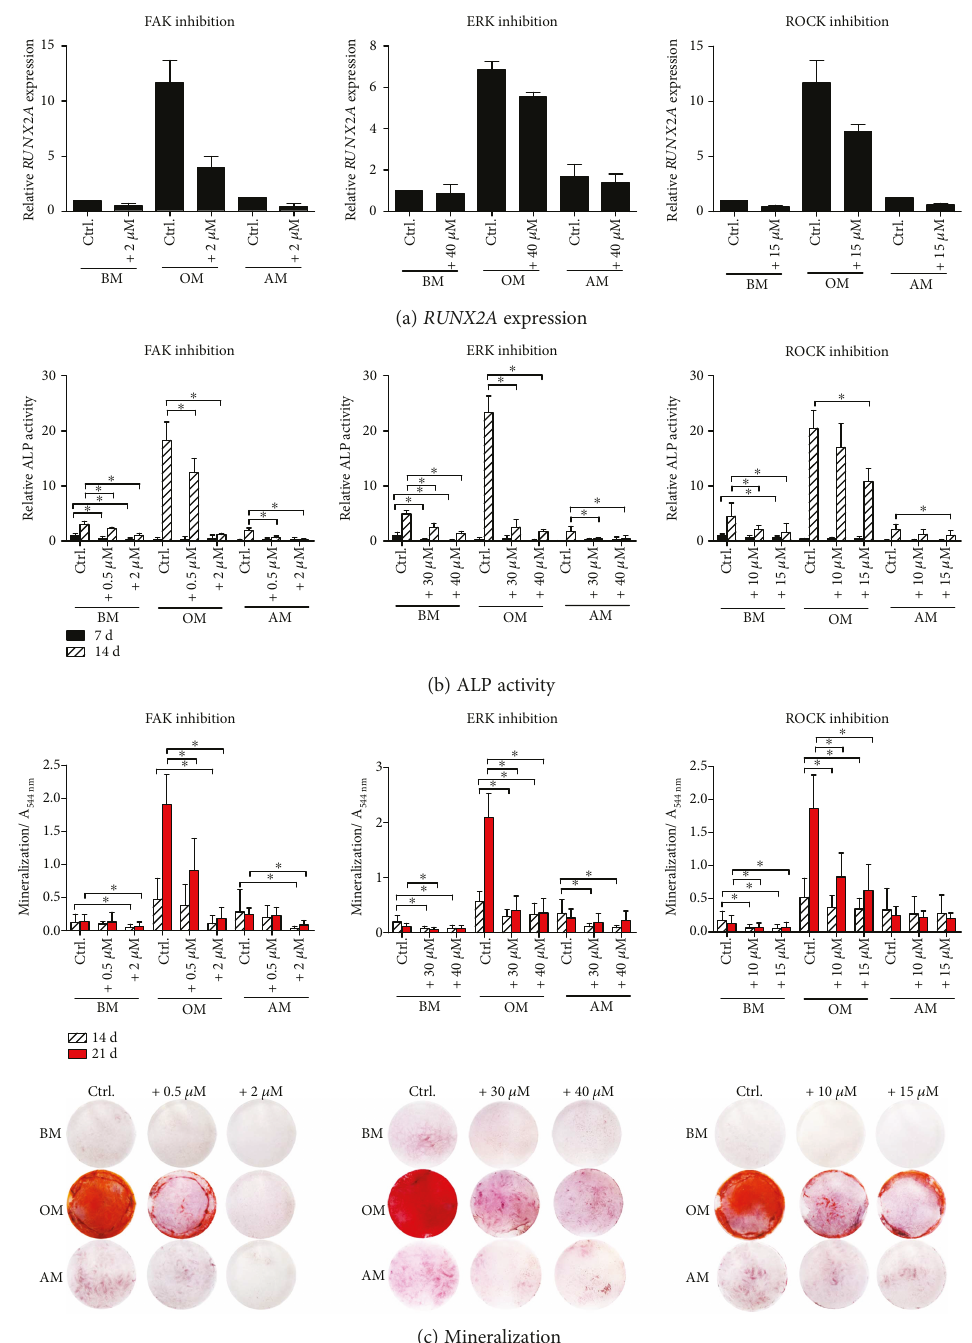
Figure 3: Osteogenic di ff erentiation of hASCs in BM, OM, and AM culture conditions supplemented with FAK, ERK, and ROCK inhibitors. (a) The cells were cultured in BM, OM, or AM supplemented with 2 μ M FAK, 40 μ M ERK, or 15 μ M ROCK inhibitors in addition to medium controls. RUNX2A expression was analyzed with qRT-PCR at 7 d. FAK and ROCK: N = 5 (independent experiments, 5 donors), ERK: N = 3 (independent experiments, 3 donors). (b) ALP activity was analyzed with ALP assay at 7 d and 14d. The ALP absorbance values were normalized with corresponding CyQUANT results, and the results are presented relative to the 7d BM sample. Signi fi cance level 5%, designated with an asterisk ( ∗ ). FAK, ERK, ROCK: N = 9 (independent biological replicates from 3 donors). (c) Matrix mineralization was analyzed with AR staining after 14 d and 21 d of culture. Quantitative results of AR staining are presented as graphs and corresponding representative images of the stained wells (21 d, area 1.9 cm 2 ) are presented below; bright red dye represents mineral. Signi fi cance level 5%. FAK, ROCK: N = 18 (independent biological replicates from 6 donors, control condition values of the graphs are the same since the experiments were conducted at the same time), ERK: N = 15 (independent biological replicates from 5 donors). BM: basic medium; OM: osteogenic medium; AM: adipogenic medium; ALP: alkaline phosphatase; AR: Alizarin